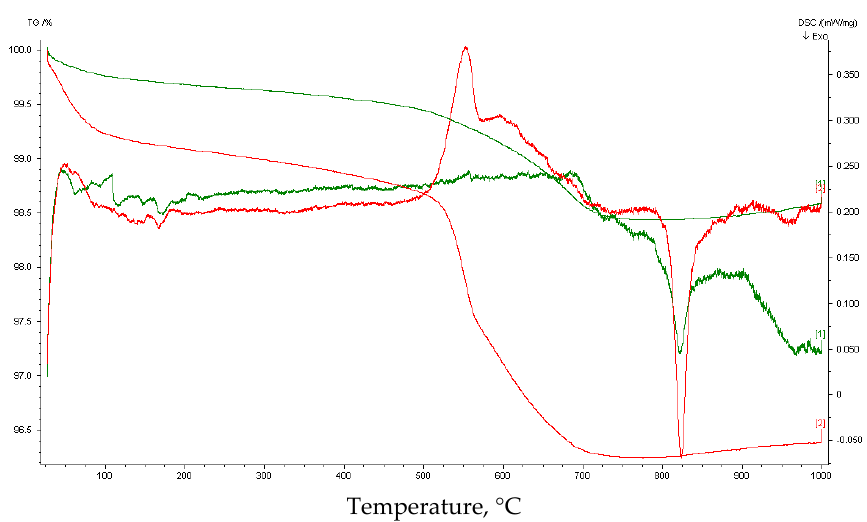
Figure 10. TGA and DSC Analysis in the experiments 1 and 2 (TGA and DSC for experiment 1- green color; TGA and DSC for experiment 2- red color).